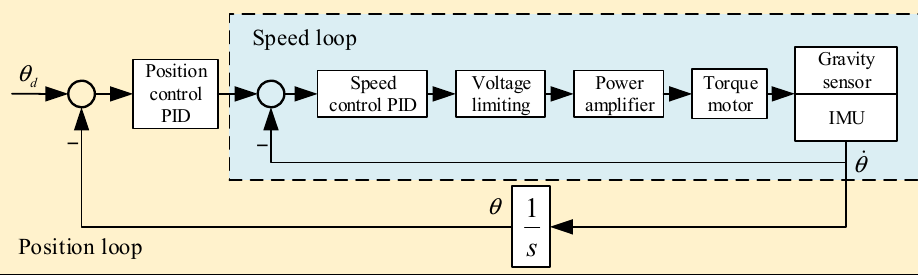
Figure 4. The hybrid control structure diagram.